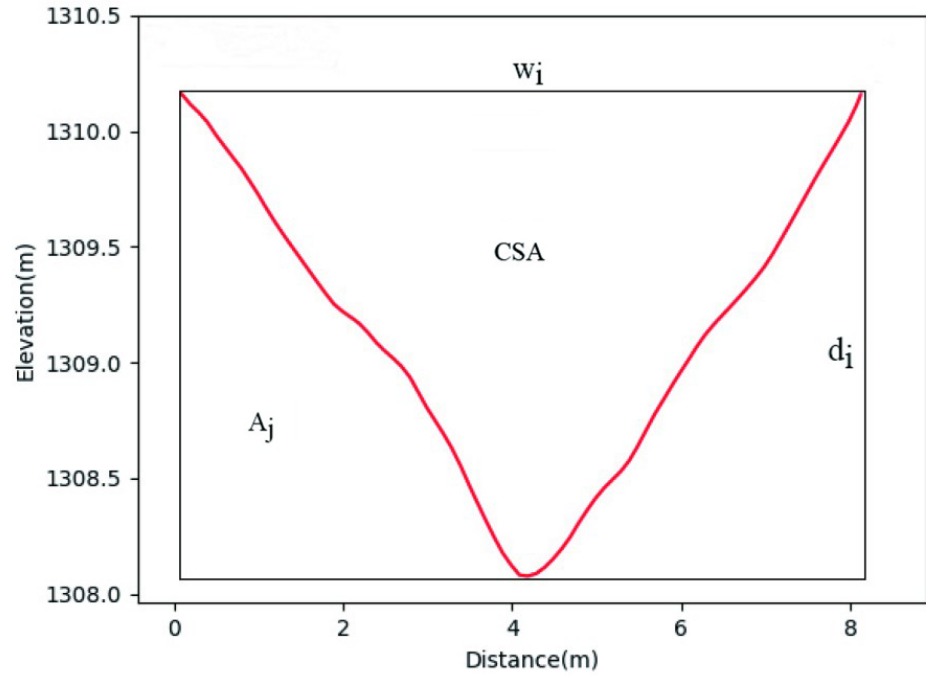
Figure 5. Sketch map for the measurement of gully cross-section (w i , width; d i , depth; CSA, cross- sectional area; A j , area below the cross-section line).